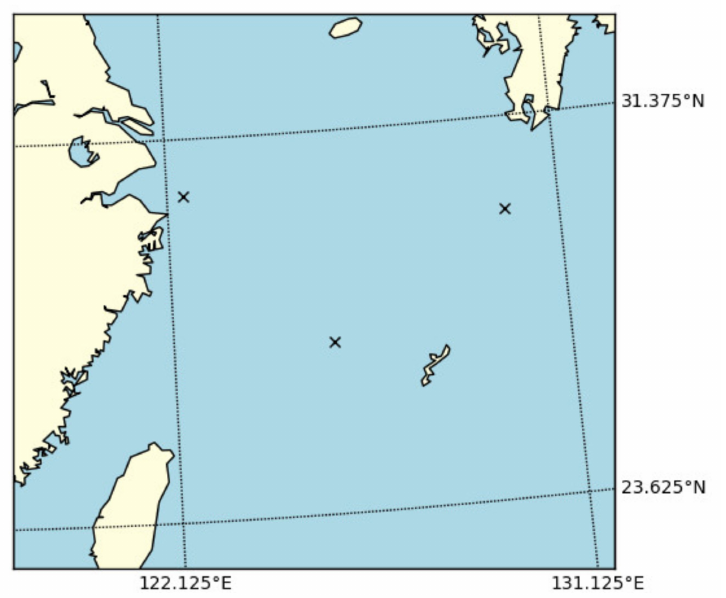
Figure 6. The three points in the selected sea